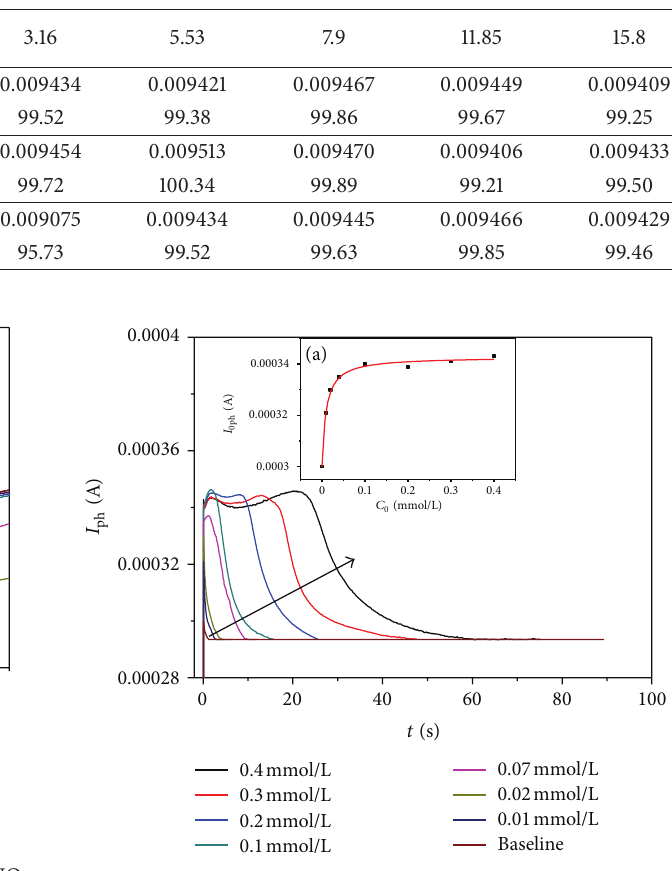
Figure 6: Photocurrent response profiles derived from the pho- toelectrocatalytic oxidation of different concentrations of benzoic acid in the thin-cell reactor based on the TNA electrodes. (a) Relationship between the initial concentration ( 𝐶 0 ) and the net peak ) of the TNA electrode for benzoic photocurrent ( 𝐼 0 ph